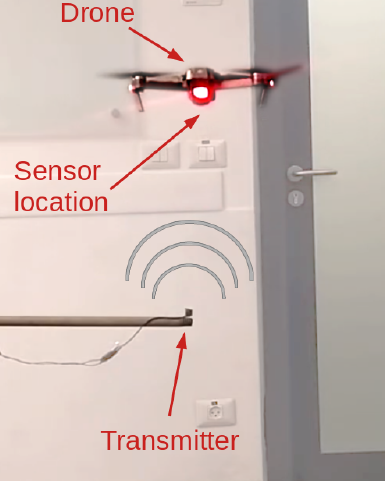
Figure 10. The real setup involving the drone. The drone is positioned above the transmitter. The transmitter is small enough so as not to be detected by the